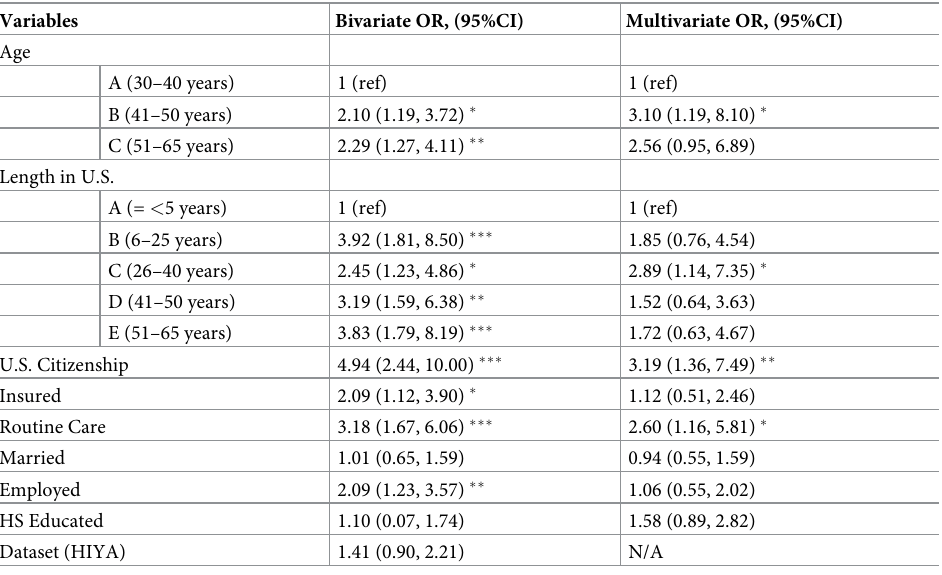
Table 3. Bivariate and multivariate logistic regression statistics.